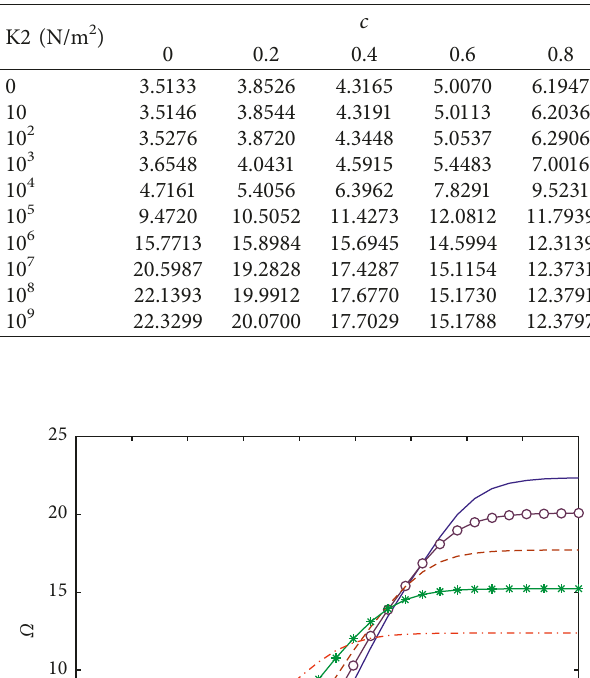
Figure 3: Nondimensional fundamental and second mode frequencies of the nonuniform double-beam system with c Mode 1; (b) mode 2.